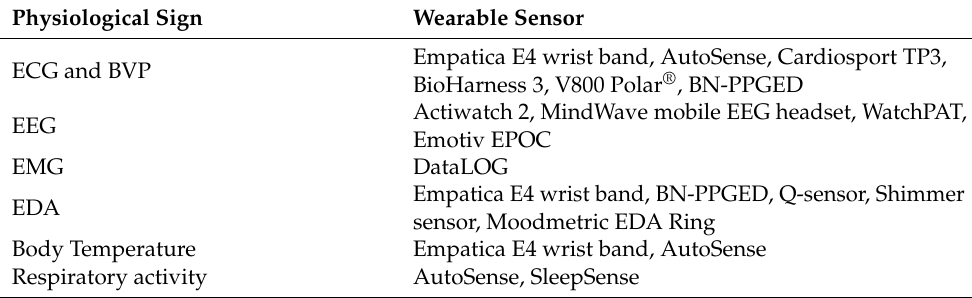
Table 2. Commercialized wearable sensors to detect physiological